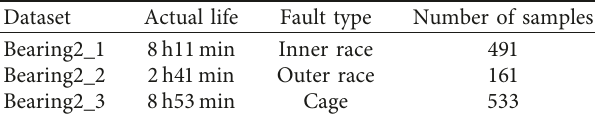
Table 2: Data introduction (XJTU-SY bearing